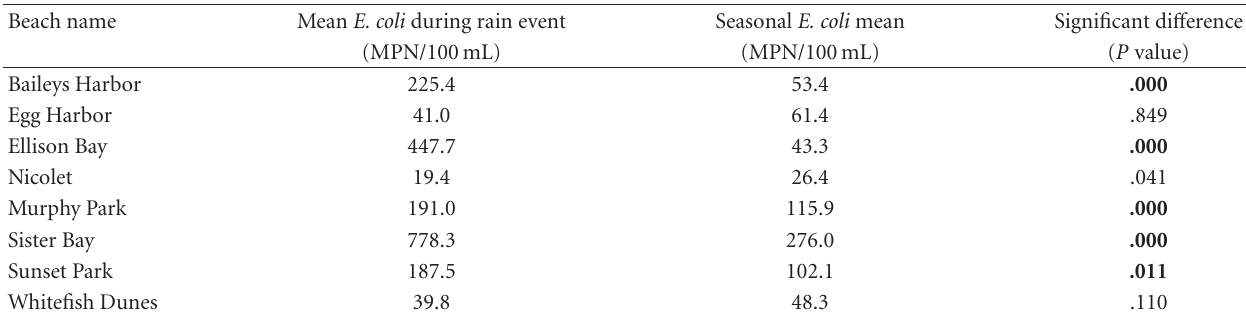
Table 1: Overall impact of rainfall on E. coli concentrations in beach water. Mean E. coli concentration in beach water during a rainfall event was compared with the seasonal mean E. coli concentration at the same beach by analysis of variance. All beaches, except Nicolet Bay Beach, had a total of ten rain events with 7 samples collected per 24-hour sampling event. Nicolet Bay Beach had four rain sampling events. Bolded P -values indicated significantly higher E. coli concentrations during rain events ( P < . 05).